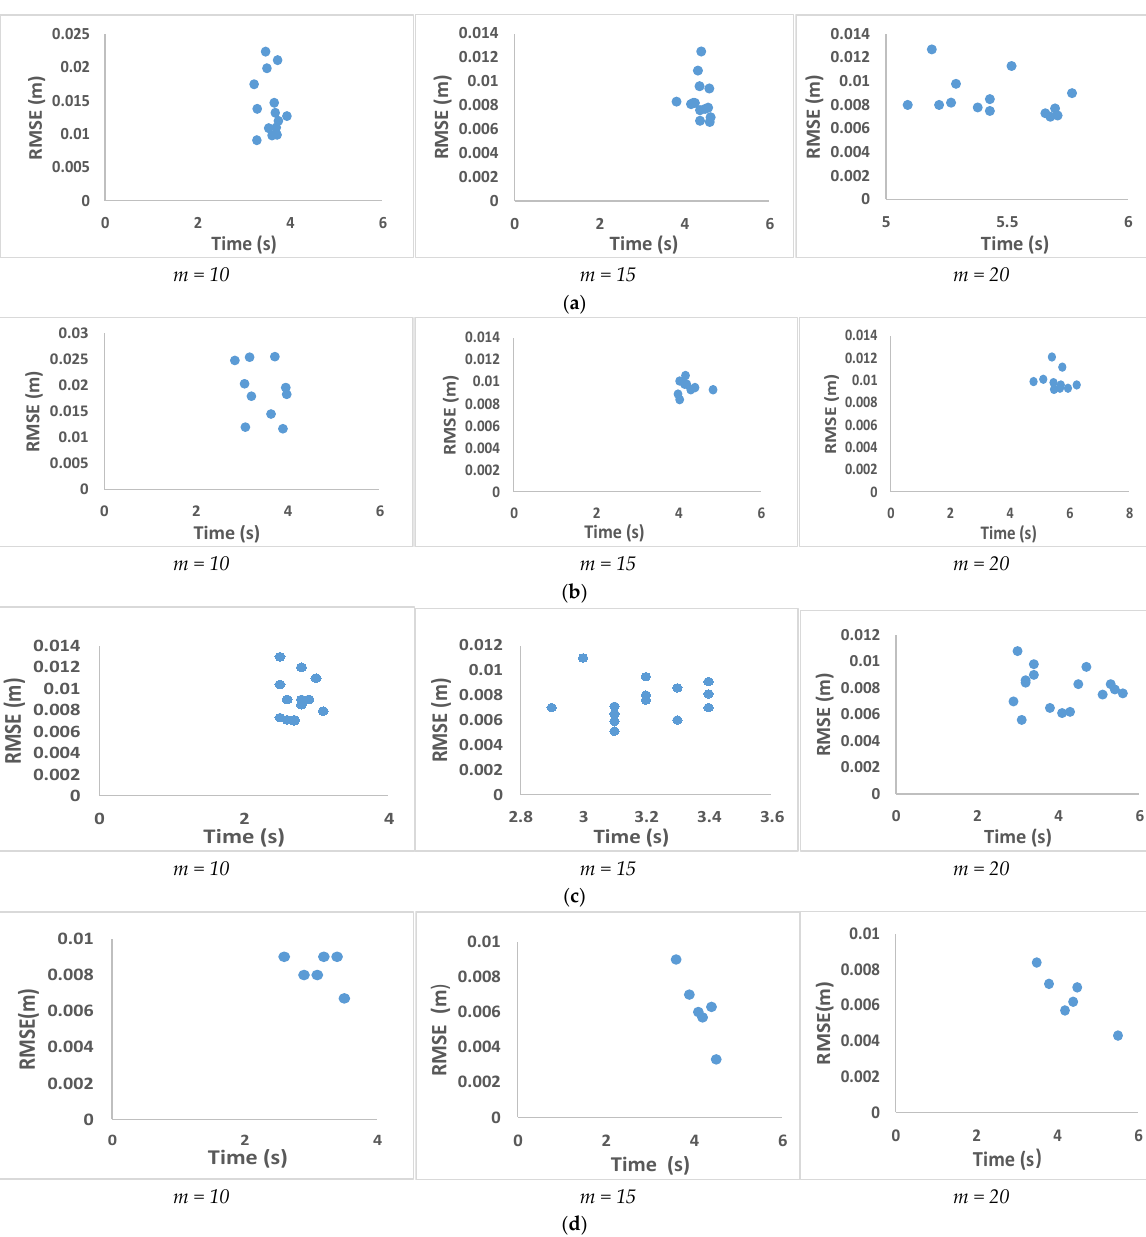
Figure 15. ( a – c ) The x axis, y axis, and z axis, respectively, as the main axis of rotation, time and RMSE variation of different rotation attitudes. ( d ) Time and error changes when the service spacecraft approaches from far to near. The cross-source point cloud fusion algorithm proposed in this paper has a higher accuracy than the other two algorithms [34,36]. The number of point clouds in a frame obtained at different distances is quite different. In the semi-physical experiment, we col- lected 40 frames of point cloud for each distance. Table 6 shows the average number of